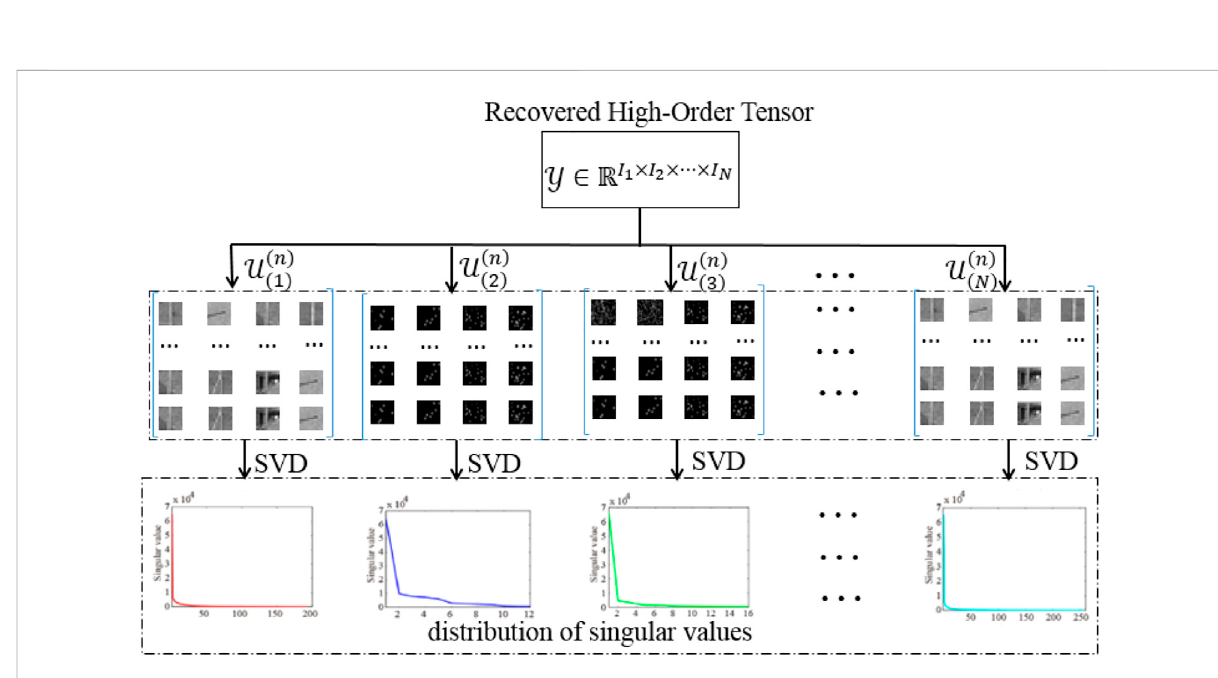
FIGURE 5 The distribution of the singular values of unfolding